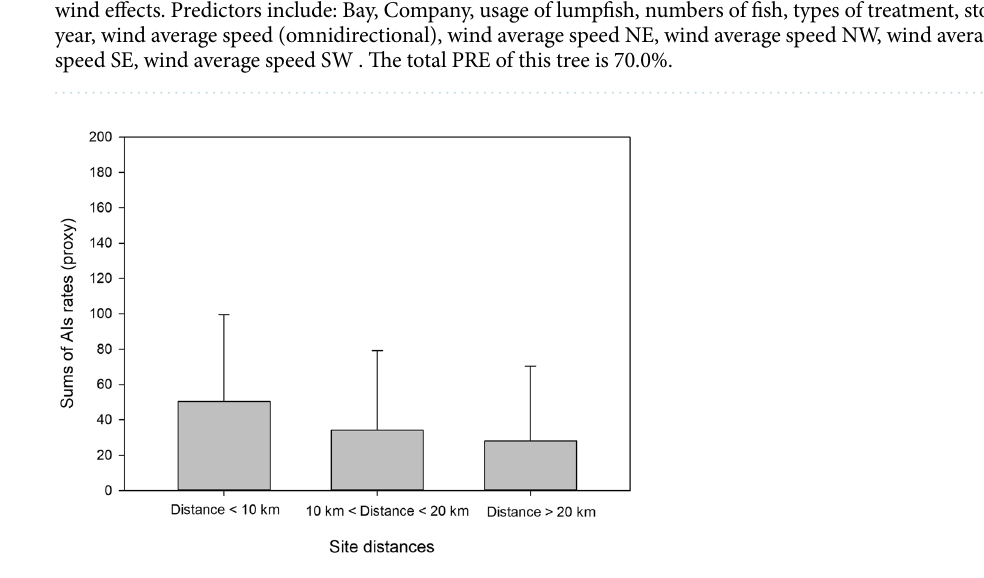
Figure 10. Average and standard deviations of chemical usage per site (proxy calculated as the sum of normalized active ingredient rates (AIs)) in relation to distances to adjacent treated sites. Distances are expressed as either < 10 km, between 10 and 20 km or higher than 20